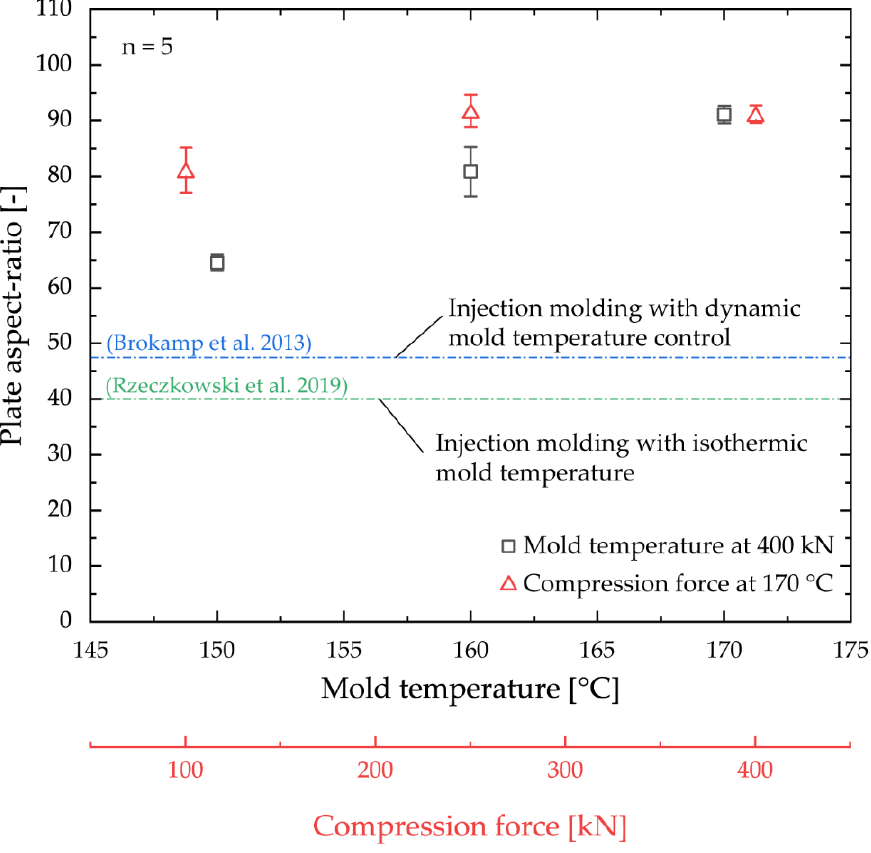
Figure 9. Molded plate aspect ratio as a function of mold temperature and set compression force compared with literature values